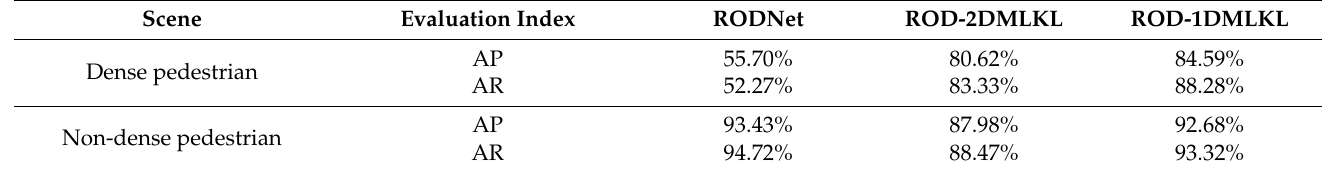
Table 2. Comparison of the results of the method proposed in this paper with those in the original